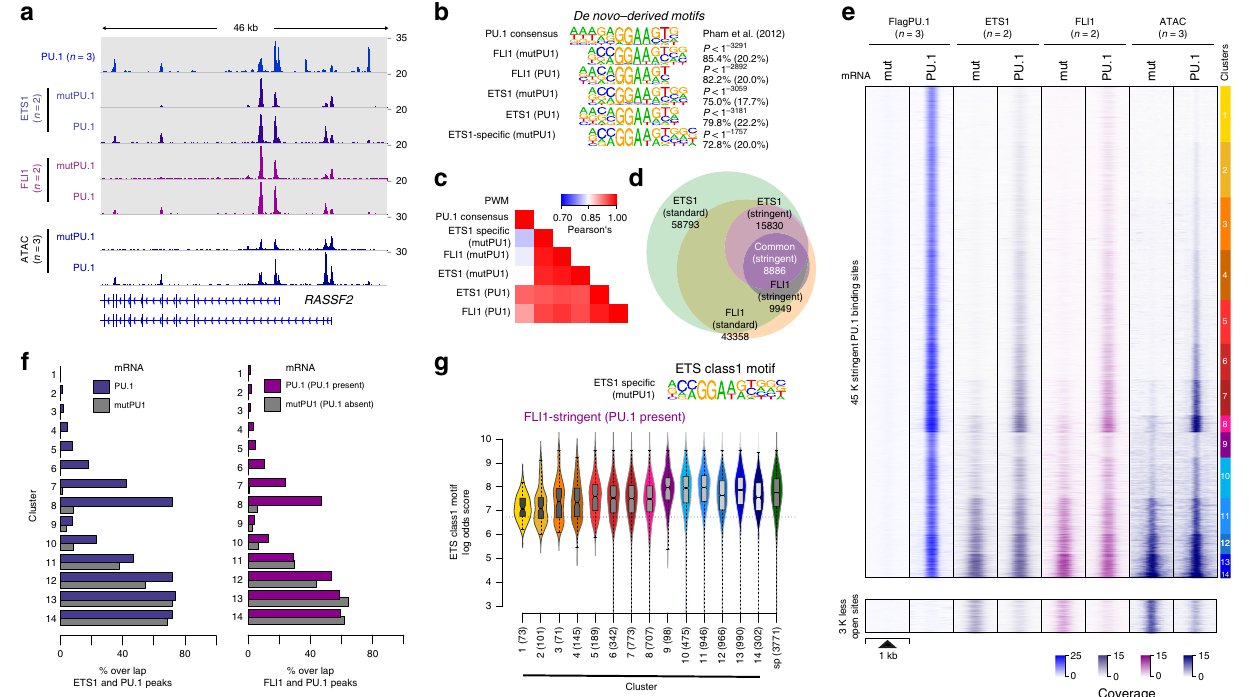
Fig. 6 Overlap between ETS1/FLI1 and PU.1-binding sites. a IGV genome browser tracks of the RASSF2 locus showing average PU.1 (blue), ETS1 (purple), and FLI1 (pink) ChIP-seq coverage in control (mutPU.1) and PU.1-expressing cells. ATAC-seq coverage of PU.1-transfected and control cells are depicted in blue below the ChIP-seq tracks. b De novo-derived motif enrichment across the indicated ChIP-seq peaks. c Correlation matrix heatmap for position weight matrices (PWM) of the motifs shown in b . d Venn – Euler diagram showing the overlap of ETS1 and FLI1 ChIP-seq peaks (using stringent and standard peak calling). e Distribution of PU.1, ETS1, and FLI1 ChIP-seq, as well as ATAC-seq signals before and after PU.1 expression plotted across the ATAC-seq-derived PU.1 peak clusters (top panel), as well as regions that lost accessibility after PU.1 induction (bottom panel) in CTV-1 cells, as introduced in Fig. 3. f Bar plots displaying the overlap of stringent ETS1 (left panel) and FLI1 (right panel) peaks in PU.1-transfected (blue/purple bars) and control CTV-1 cells not expressing PU.1 (gray bars) with PU.1 peaks across the PU.1 peak clusters introduced in Fig. 3. g Motif log odds score distribution of the consensus ETS class 1 motif is shown for FLI1-overlapping peaks across ATAC-seq-derived PU.1 peak clusters along with FLI1 speci fi c (sp) peaks. The median of each distribution is depicted inside the bean with a conventional boxplot. b – g Source data are provided as a Source Data fi